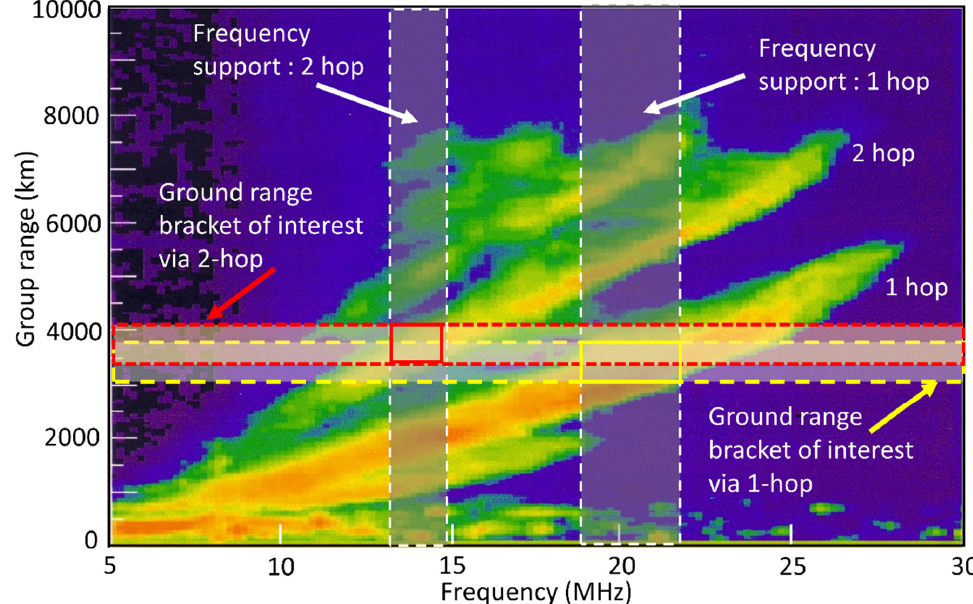
Figure 4. A backscatter sounding showing the frequency support for the selected ground range bracket of interest. Both the 1-hop and 2-hop modes provide illumination, with available frequency bands [18.7–22.7] and [12.5–14.2] MHz, respectively. The 2-hop mode has a longer group delay for the same ground range because it includes two ascents to the ionosphere. The resulting windows of useful propagation are shown in the yellow and red boxes marked with solid lines.